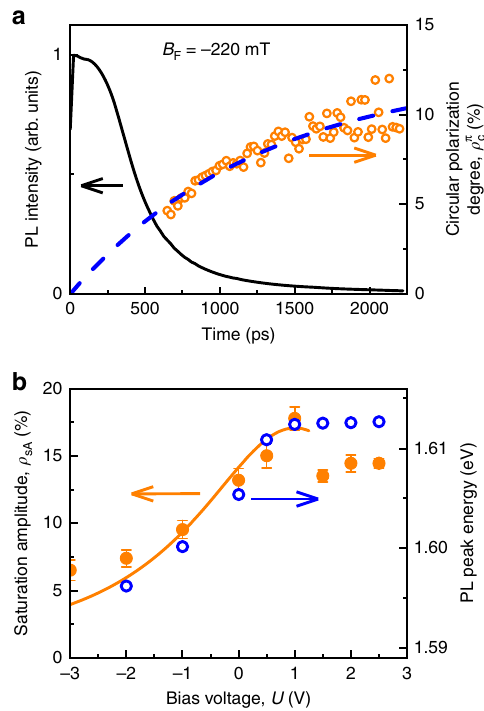
Fig. 3 Time-resolved photoluminescence (PL). a The kinetics of the PL intensity (black solid line) and the degree of circular polarization of the PL (open orange circles) integrated in the spectral region of e-A 0 at U = 0. Blue dashed line is a fi t to the data. b Dependence of ρ sA ( U ) of the FM proximity effect (full orange circles) and the position of the PL peak ħ ω U ) (open blue circles) on the bias voltage U . The solid curve is max ( calculated using Eq. (8) with A = 17 %, U 0 = 1.0 V, and U 1 = 2.0 V. Error bars represent standard applied magnetic fi eld (see Fig. 4b). However, when the magnetic fi eld is extrapolated to zero, the Stokes shift of the line e tends to zero, while the lines h and e + h show a negative offset. This means that both SFRS lines h and e + h are in fl uenced by the exchange effect of gate voltage on the exchange coupling strength. The zero fi eld offset represents a direct measurement of the exchange